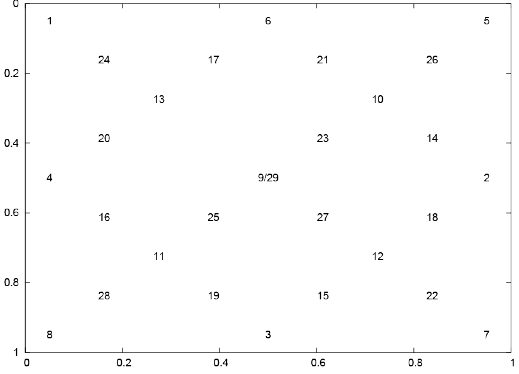
Figure 1. The layout of the jumping point